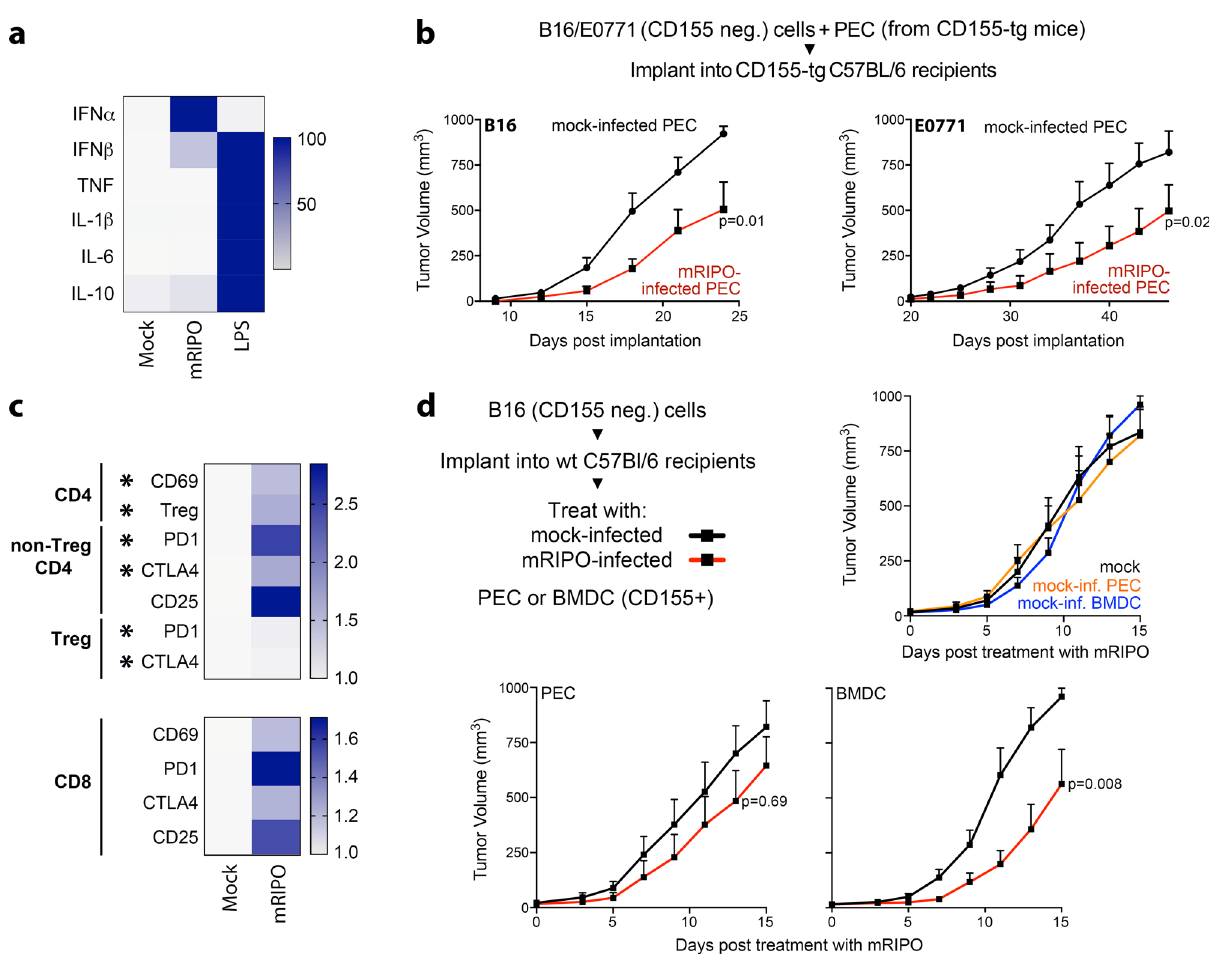
Fig. 2 PVSRIPO-infected myeloid cells delay tumor growth. a Peritoneal exudate cells (PEC) from CD155-tg mice were treated with mock, mRIPO [multiplicity of infection (MOI) of 10], or LPS (100 ng/ml) in vitro; cytokine release was measured and normalized to maximum value for each cytokine across all treatments (n = 2 experiments). b Wt B16 or E0771 cells were mixed with mock or mRIPO-infected CD155-tg PEC and implanted into CD155-tg mice subcutaneous or fat pad, respectively. B16: Mock n = 9, mRIPO n = 8; E0771: n = 9 for both. c E0771 tumor-bearing fat pads were harvested 21 days post E0771 + PEC ( − / + mRIPO) implantation and analyzed by fl ow cytometry ( n = 5/group); see Supplementary Fig. 5 for gating strategy. Asterisks indicate t test p < 0.05 (two-tailed; from top to bottom: p = 0.03, 0.01, 0.02, 0.02, 0.01, 0.02), values represent fold-mean mock %positive. d Wt mice bearing B16 tumors were injected with CD155-tg PEC or FLT3L-derived BMDCs after ex vivo pre-treatment with mock or mRIPO (MOI 10; 24 h) as shown; n = 9 mock and mRIPO-infected PEC, n = 8 PEC/BMDC (mock) and mRIPO-infected BMDCs. b , d Mean tumor volume + SEM is shown and p-values are from two-way ANOVA (two-tailed). All experiments were repeated at least twice and a representative series is